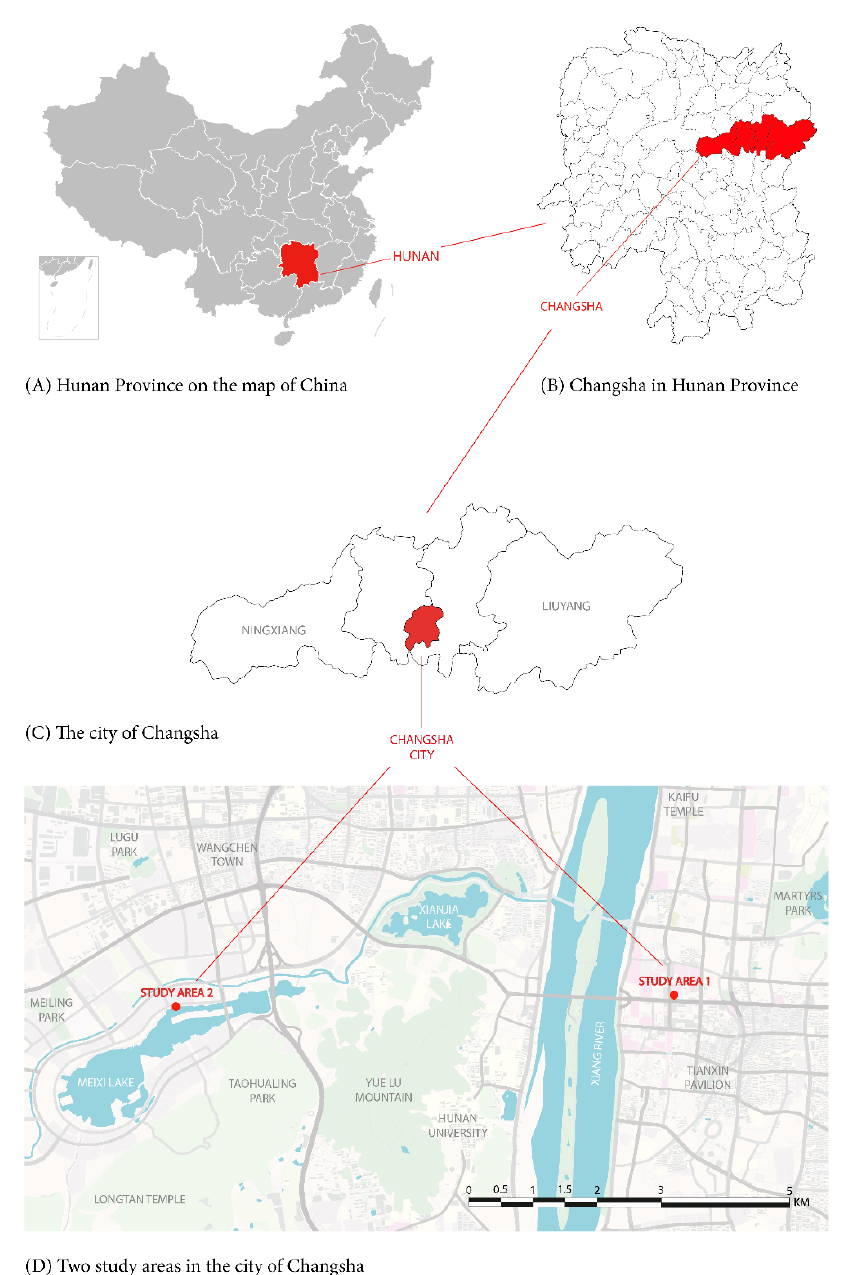
Figure 2. Locations of study areas.